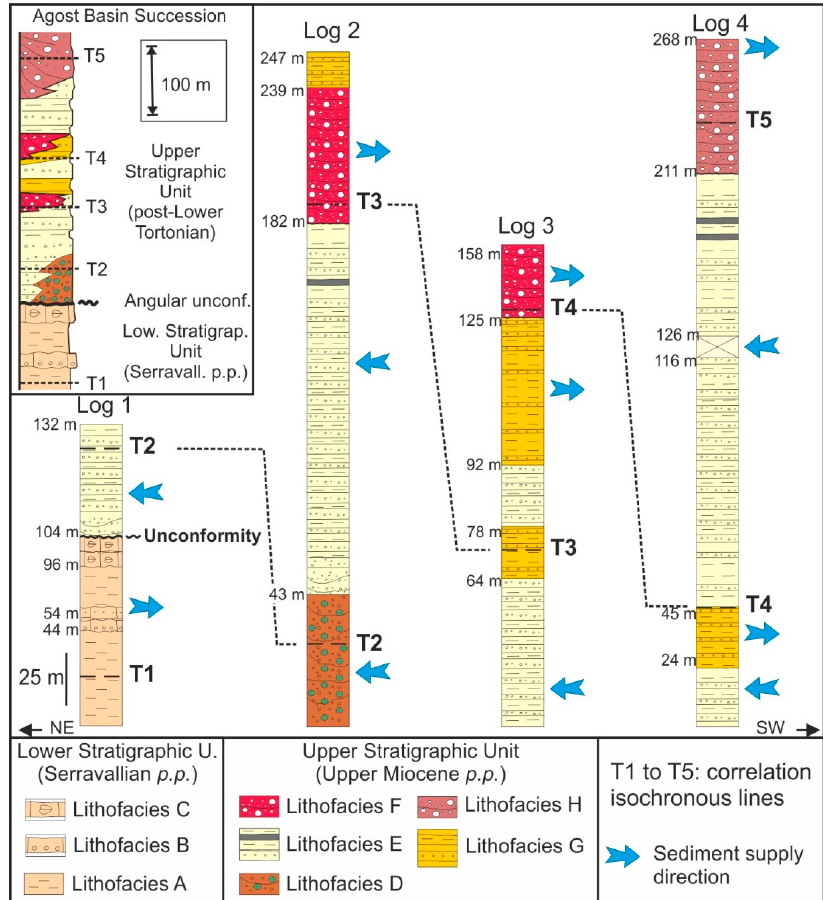
Figure 7. Stratigraphic columns of the Neogene stratigraphic units of the Agost Basin (Alicante province) of the eastern EBZ (after Reference [22]; modified). Four stratigraphic sections are presented to characterize the succession of the Agost Basin. Two stratigraphic units (Serravallian p.p. and Upper Miocene p.p. in age, respectively) were identified. Five isochronous lines are used for correlation deduced from the geological map. The direction of the sediment supply is indicated by the blue arrows, while a synthetic column is presented in the upper left